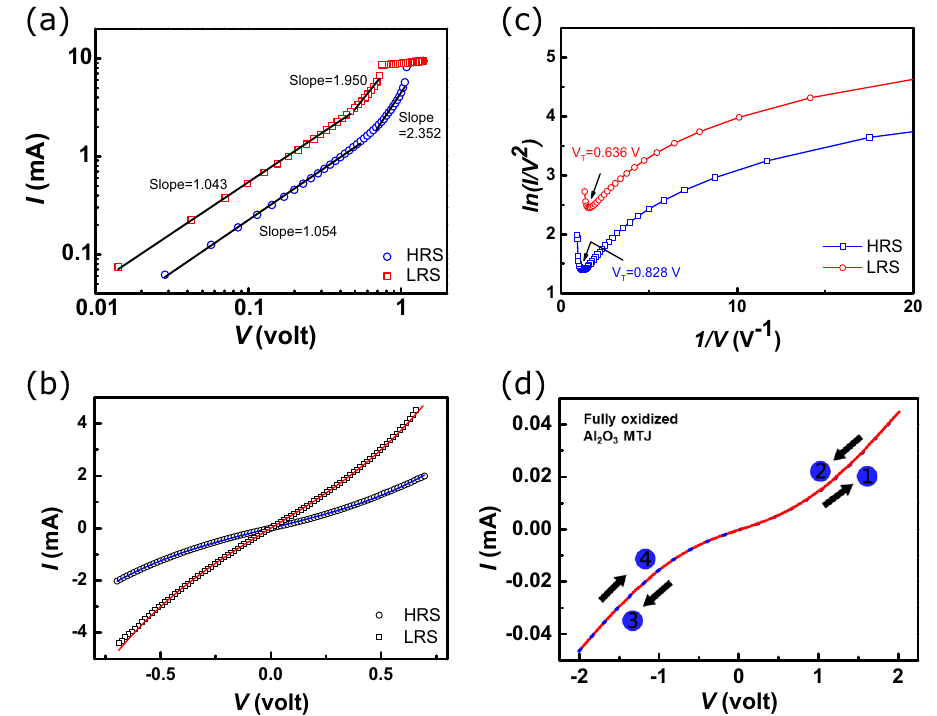
Figure 3. ( a ) The linear fits (black solid lines) of the I–V curves in double-logarithmic scales for the positive voltage region. ( b ) The fitting results at low bias voltage using the Simmons model. The plot in ( c ) indicates the transition from direct tunneling (DT) to Fowler-Nordheim (FN) tunneling at V = V T (see text). ( d ) The I–V curve of a fully oxidized Al 2 O 3 MTJ, which shows no resistive